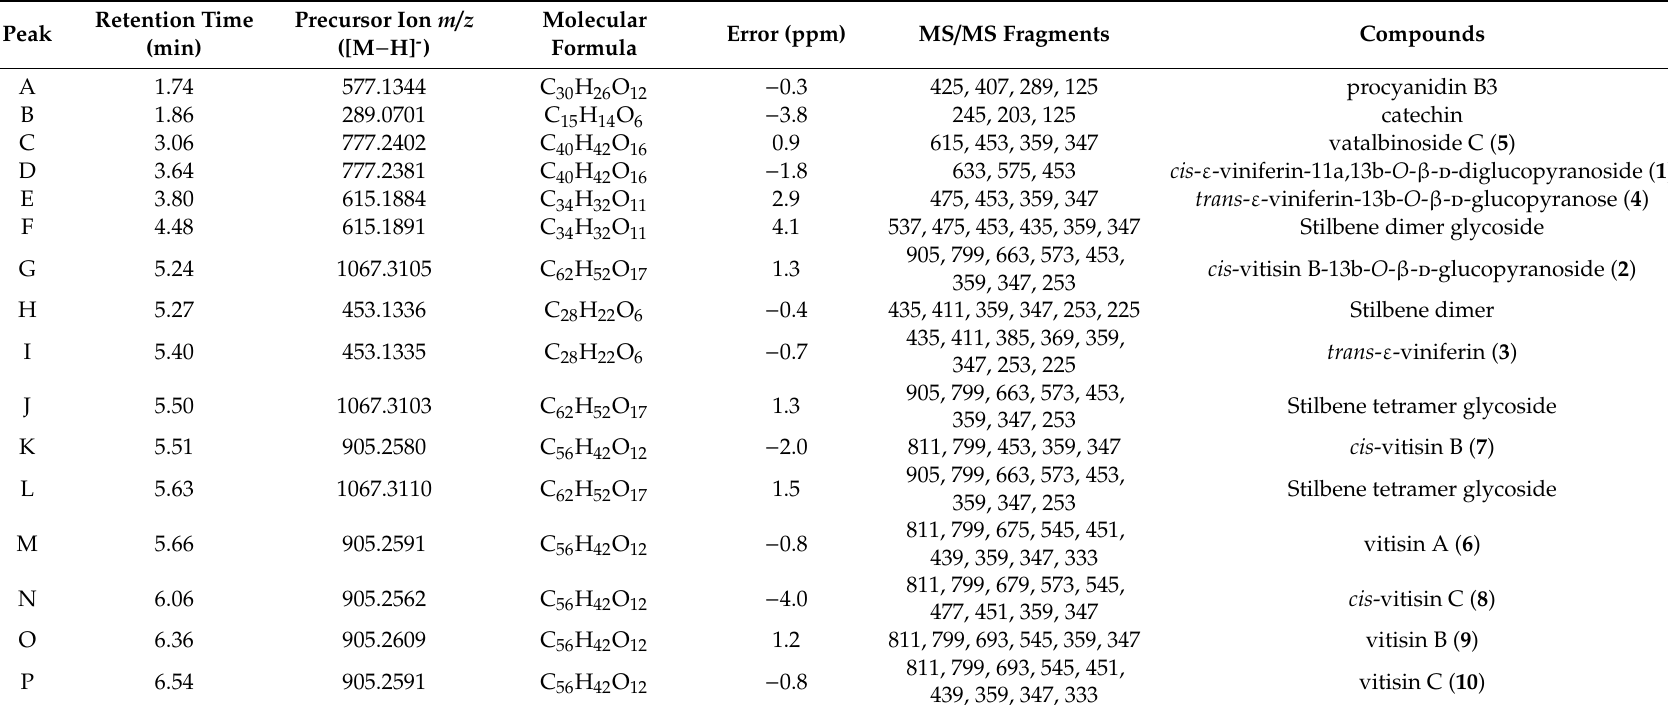
Table 1. Major chromatographic peaks in the LC-MS / MS profile of the I. lactea var . chinensis seeds